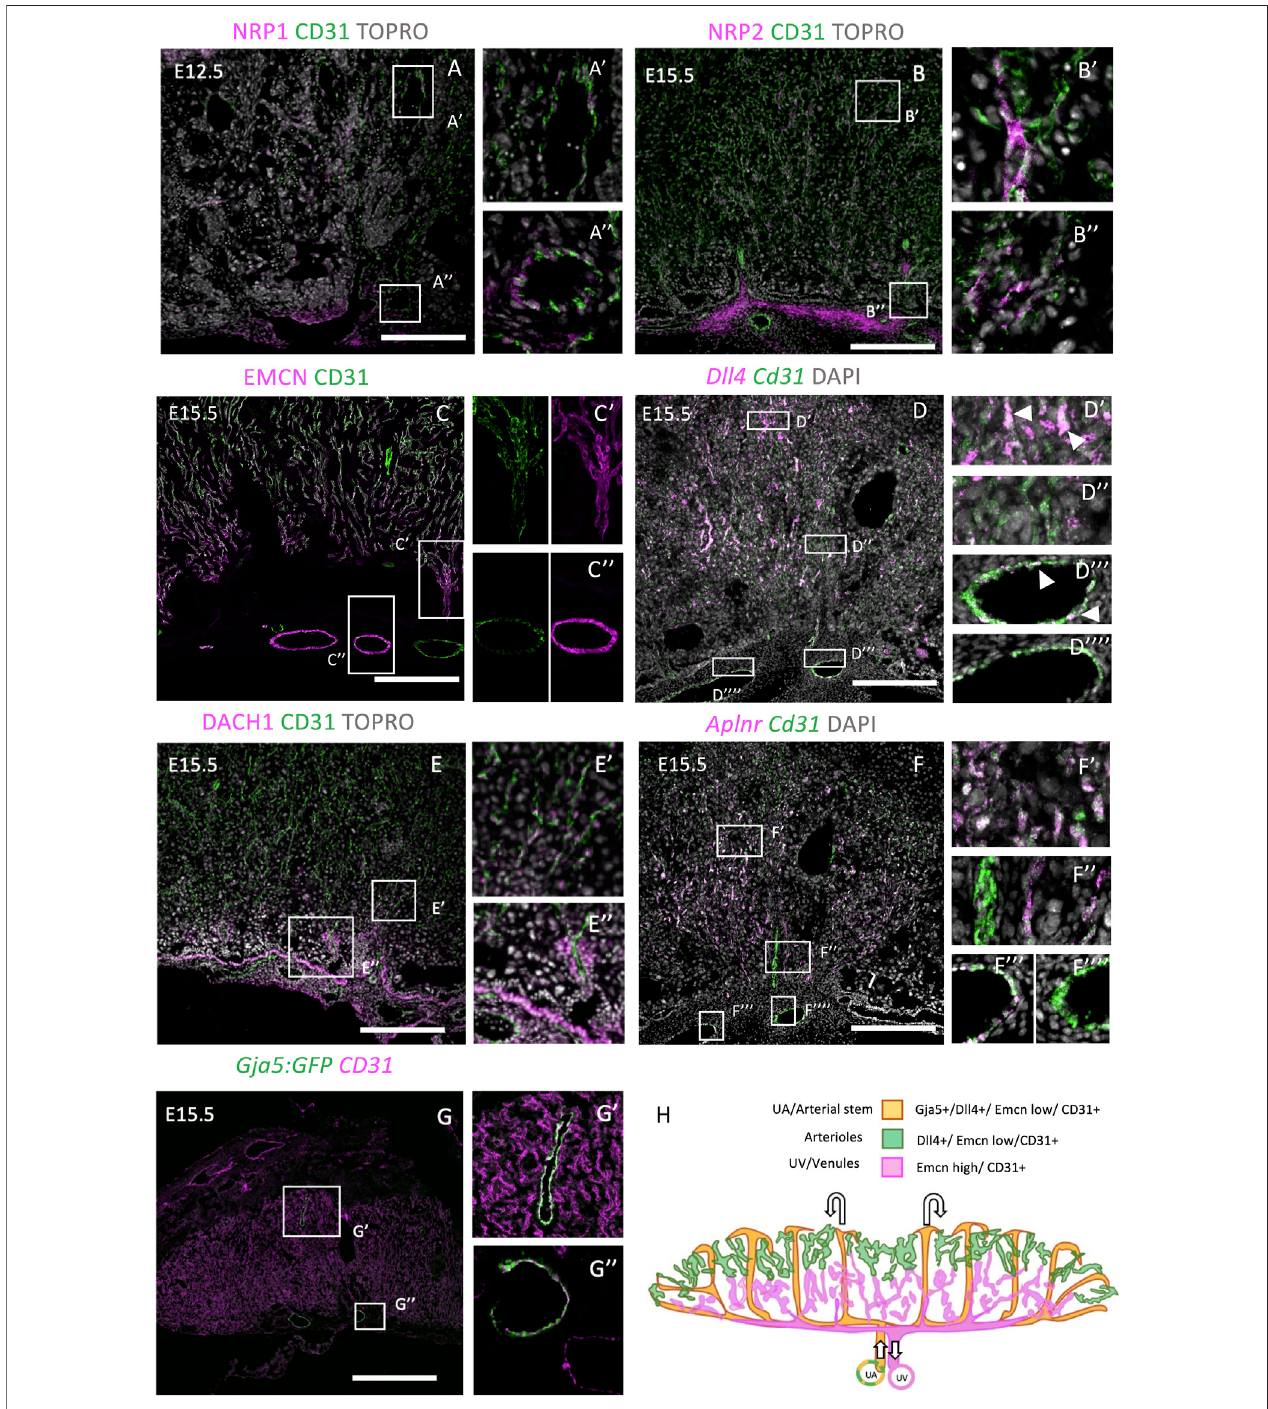
FIGURE 1 | Investigation of embryonic arterial and venous genes during mouse placentation. E12.5 or E15.5 placentae were stained with embryonic arterial- speci fi cgenes(NRP1,DACH1, Dll4 ,and GJA5:GFPinA,D,E,andG), andembryonic venous-speci fi cgenes[NRP2, Endomucin(EMCN), and Aplnr inB,C,andF].IHC was performed in (A – C, E, F) , whereas RNAscope was performed in (F) . The boxes outline the areas shown at higher magni fi cation in [A – G ( ‘ )] . (H) Diagrammatic representationofarterioles(green),arterialstems/uterineartery(orange),andvenous/uterinevein(magenta)geneswithintheE15.5placenta.Diagramwascreated by tracing cell markers and structures from placental sections. Scale bars (white) (cid:1) 200 um.